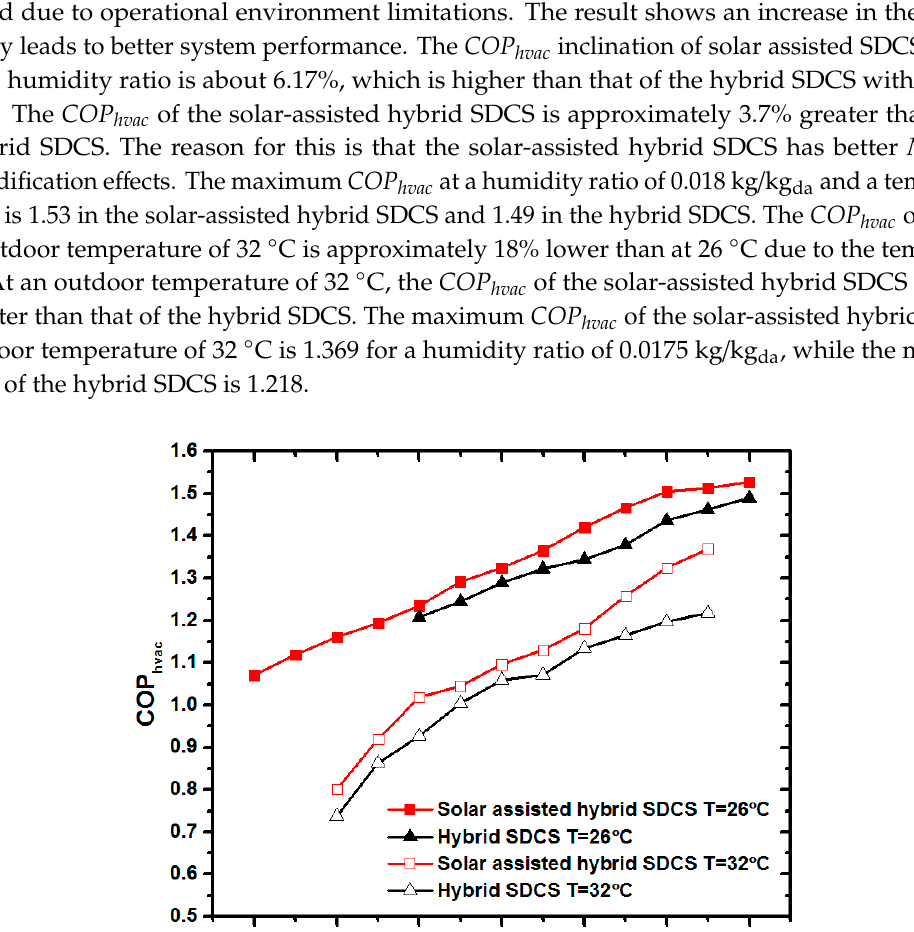
Figure 12. Comparison of COP hvac at different outdoor humidity ratios.